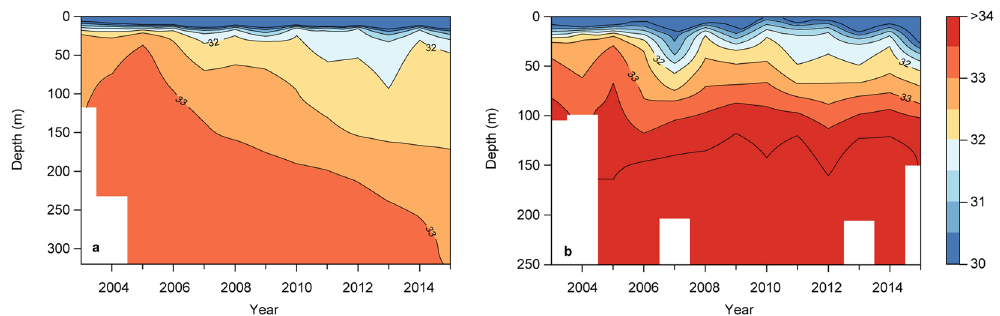
Figure 2. ( a ) Time-depth isopleths of average salinity over the study period for the fjord and ( b ) the coastal water of the hydrographical